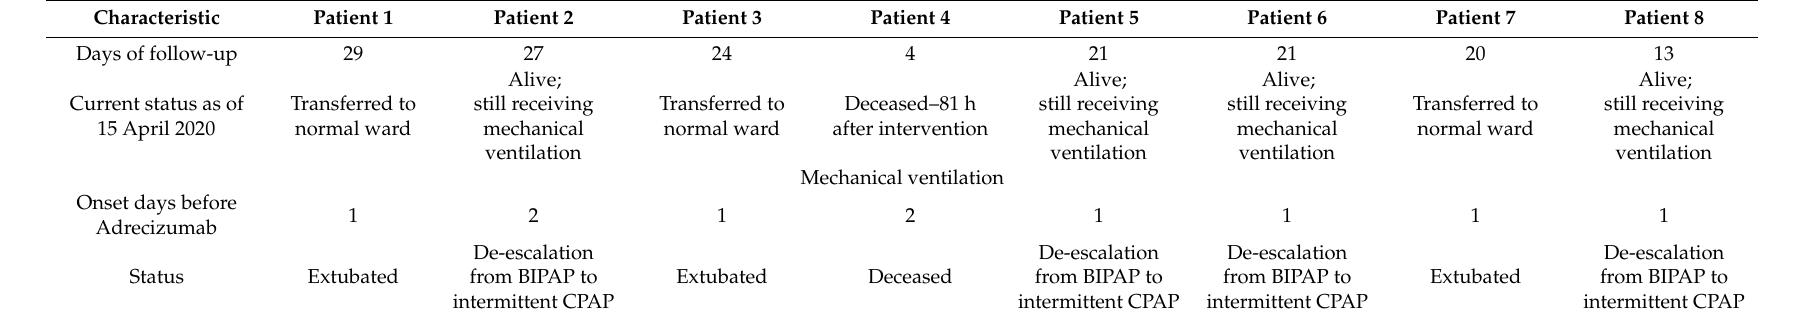
Table 3. Comparison of clinical parameters and score before and after the Adrecizumab